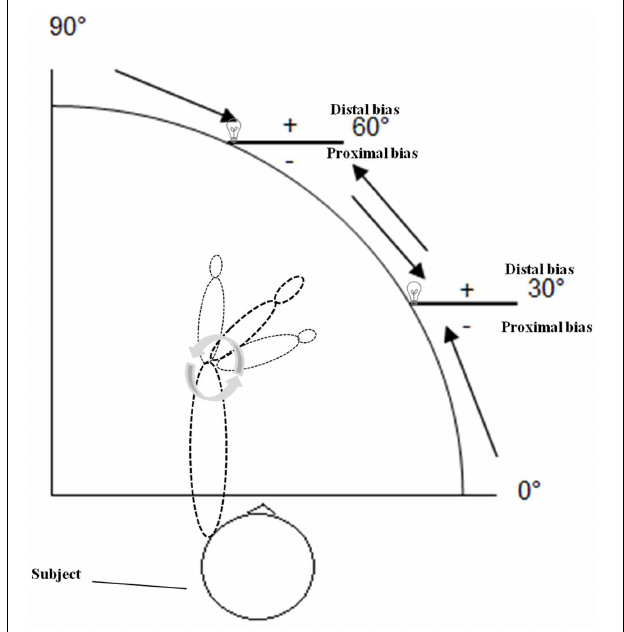
FIGURE 2 | Schematic drawing of the arm position device (APD) used in the present experiment when the left forearm was tested. Two different angle positions of the elbow joint (30 and 60 ◦ flexion) from four different starting positions: 90 ◦ (forearm completely extended), 60 ◦ flexion, 30 ◦ flexion, 0 ◦ (forearm completely bent) were tested. Participants performed six trials per LED position, that is three trials + 30 ◦ (bent movements) and three trials − 30 ◦ (extended movements) of the true target position (see direction of the arrows). Negative symbols indicate proximal deviations (toward the own body), positive symbols distal deviations (away from the own body) (see text for further